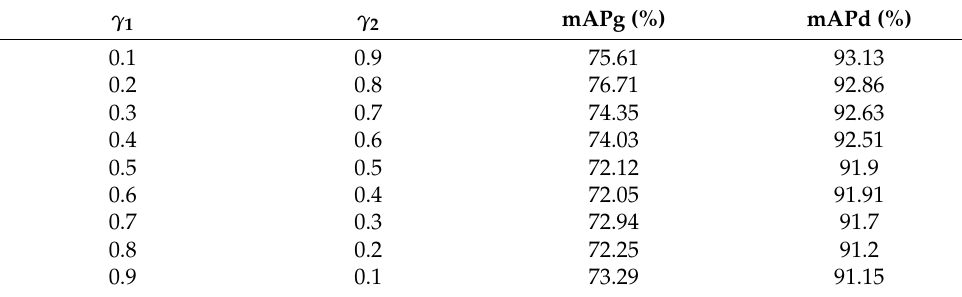
Table 5. Effect of different parameters on BR1.